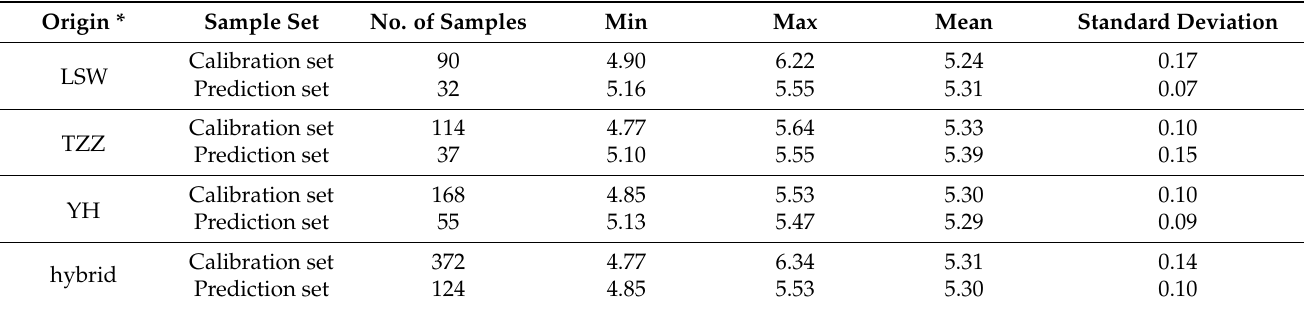
Table 2. Measured values of acidity (pH) in ‘Dangshan’ pear in the calibration and prediction data sets of four different origins.